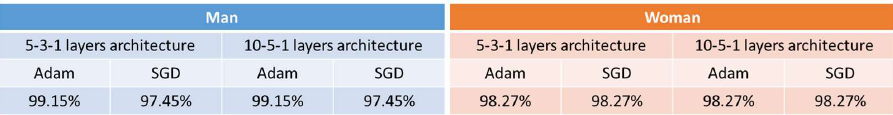
Figure 10 . Results of the DNN classifier. Figure 10. Results of the DNN classifier.